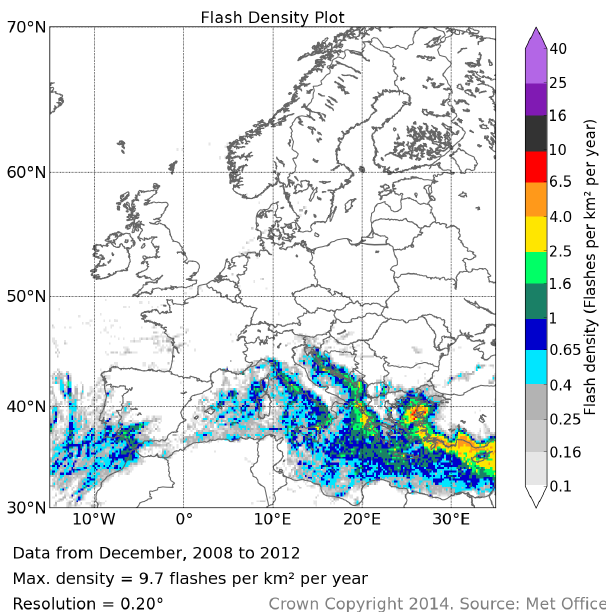
Fig. 14. Detected lightning flash density for October.